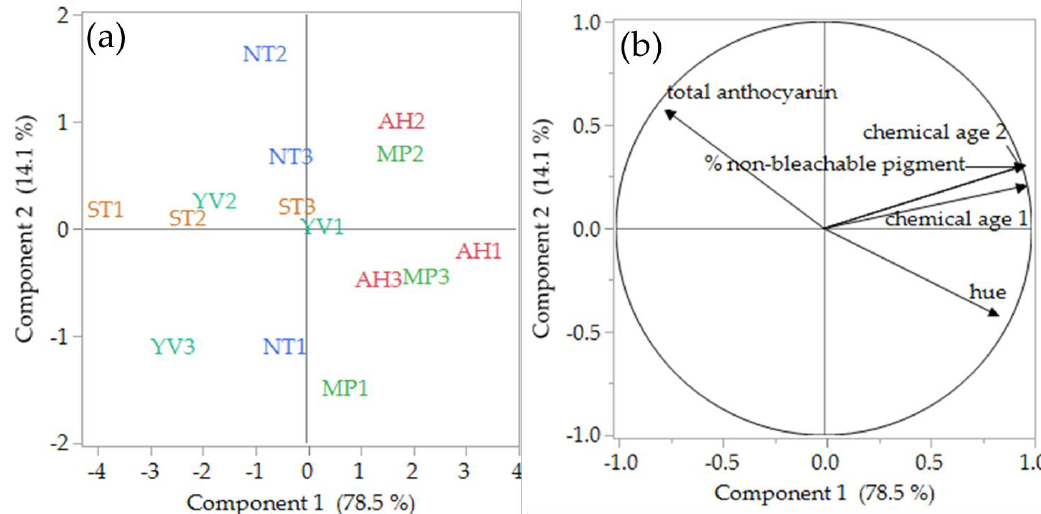
Figure 2. PCA scores ( a ) and loadings ( b ) plots of 2018 Pinot noir wines ( n = 3 per region) and significant ( p < 0.05) chromatic and colour structure attributes. Adelaide Hills; MP, Mornington Peninsula; YV, Yarra Valley; ST, Southern Tasmania; NT, Northern Tasmania.